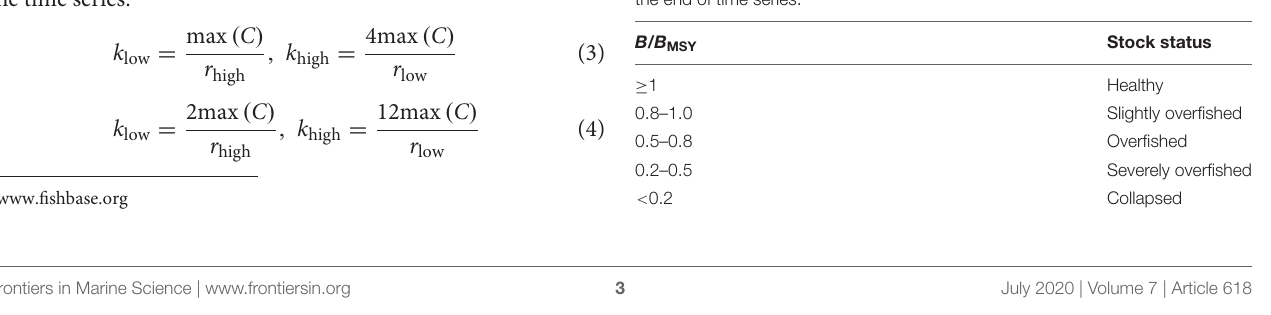
TABLE 2 | Definition of stock status (Palomares et al., 2018) based on B / B MSY in the end of time